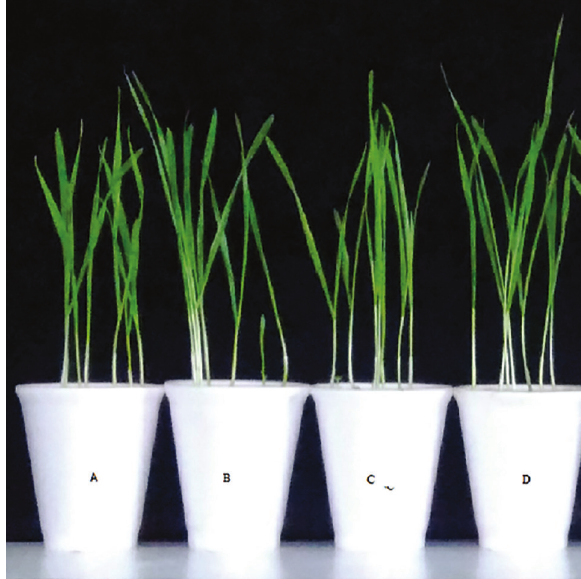
Figure 6: Shoot length (cm) of treated plants: A – control; B – T1 (bacterial AgNPs); C – T3 (BI); D – T2 (bacterial